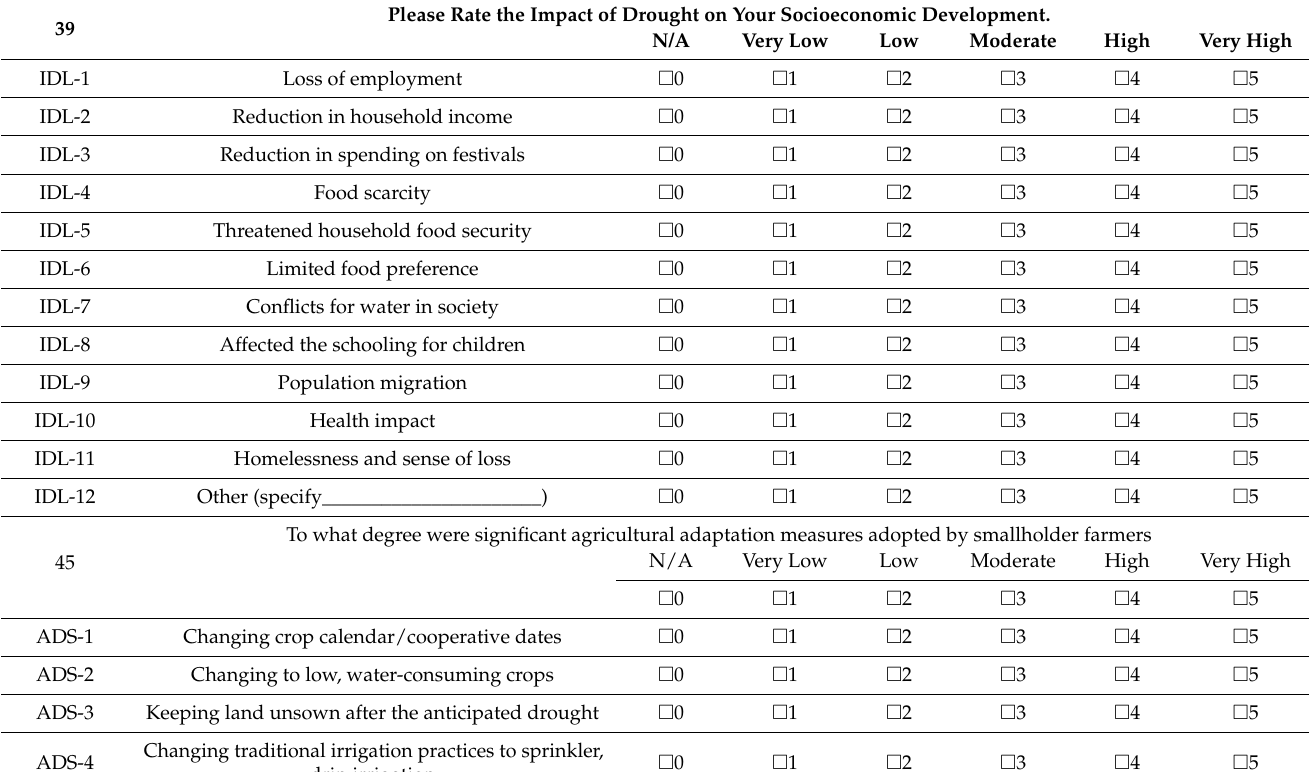
Table A1. Structured Questionnaire of the Household survey. Please Rate the Impact of Drought on Your Socioeconomic